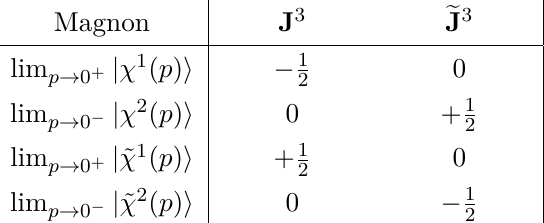
charge of massless particles. The Fermions | χ ˙ A ( p ) i have su (2) spin Table 2 . The su (2) ⊕ su (2) L R under ( J 3 − e J 3 ) equal to − 1 / 2 , while | ˜ χ ˙ A ( p ) i have +1 / 2 . Given that they all have M = 0 , the su (1 , 1) spin ( − L + e L ) follows, cf. (2.44). This is also consistent with the fact that | ˜ χ ˙ A ( p ) i = Q 1 Q 2 | χ ˙ A ( p ) i . 0 0 However, the particles are chiral depending on the sign of sin( p/ 2) , cf. (2.46). Hence, in different momentum regions they will be annihilated by either − L and J 3 or by − e L and e J 3 . Keeping 0 0